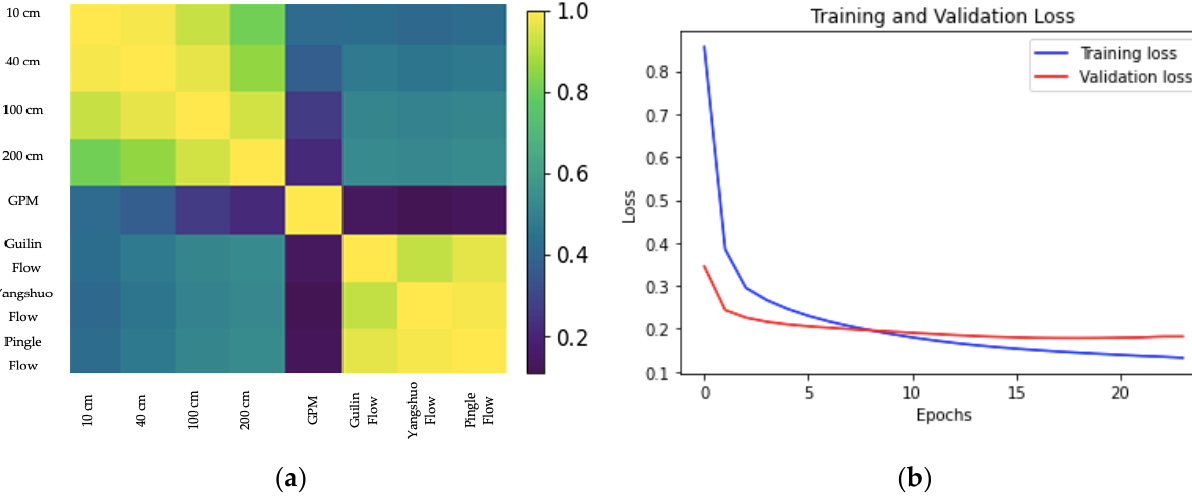
Figure 7. Daily soil moisture and runoff vs. rainfall in Guilin for 1.5 years. Soil moisture values are − 300.